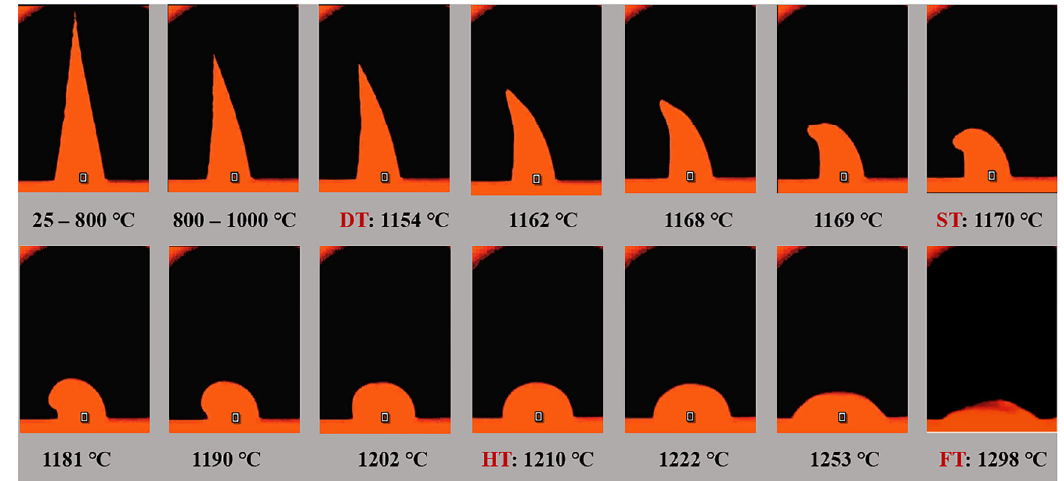
Figure 18. Discrimination of the ash fusibility of the